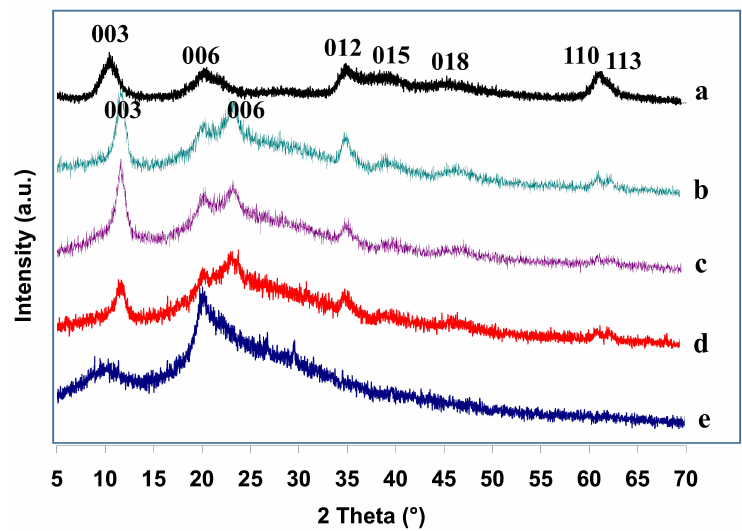
Figure 3. XRD patterns of Mg / Al-NO 3 LDH ( a ), C-LDH(2) ( b ), C-LDH(1) ( c ), C-LDH(0.5) ( d ) and pure C beads ( e